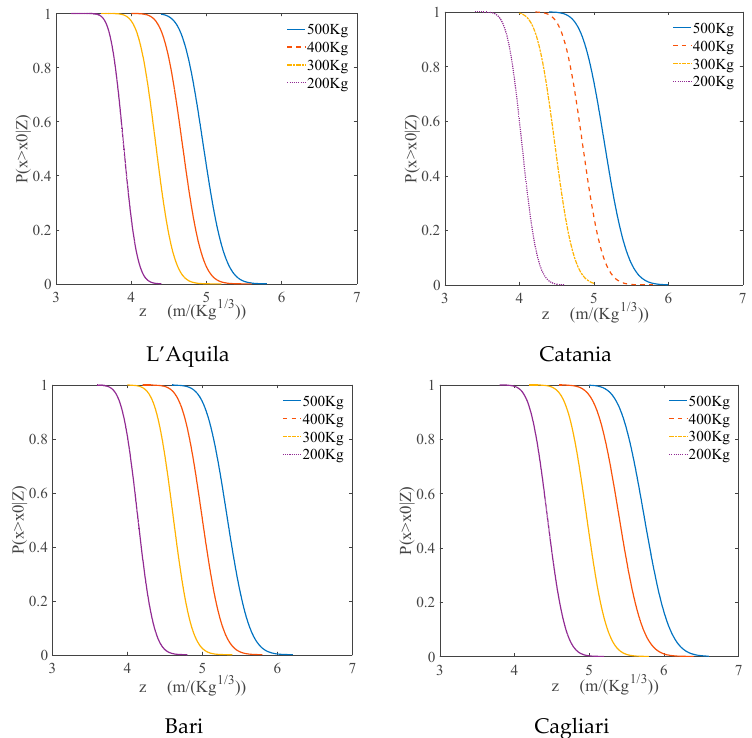
Figure 11. Fragility curves for moderate damage condition for each structure location.